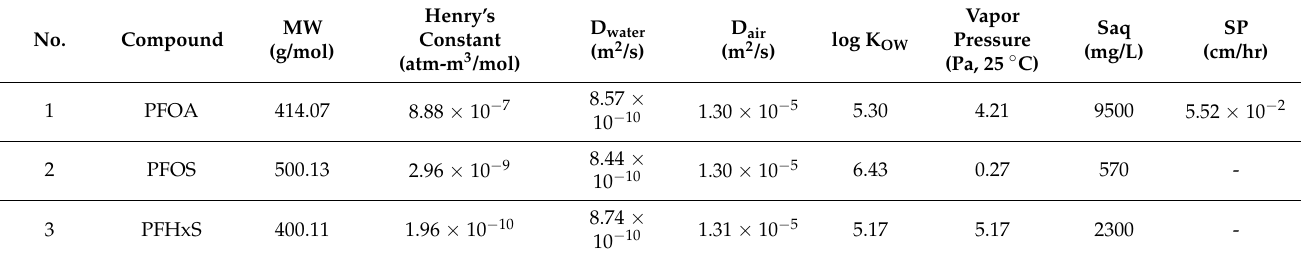
Table 3. Physicochemical parameters for human risk assessment of PFASs.